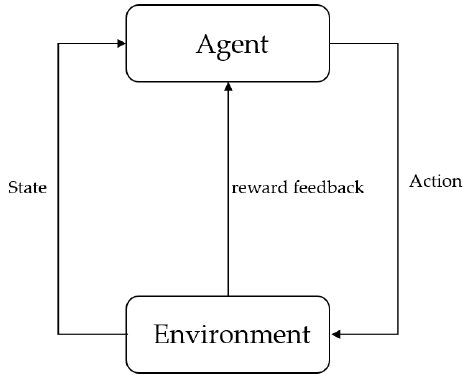
Figure 2. Reinforcement learning basic model.